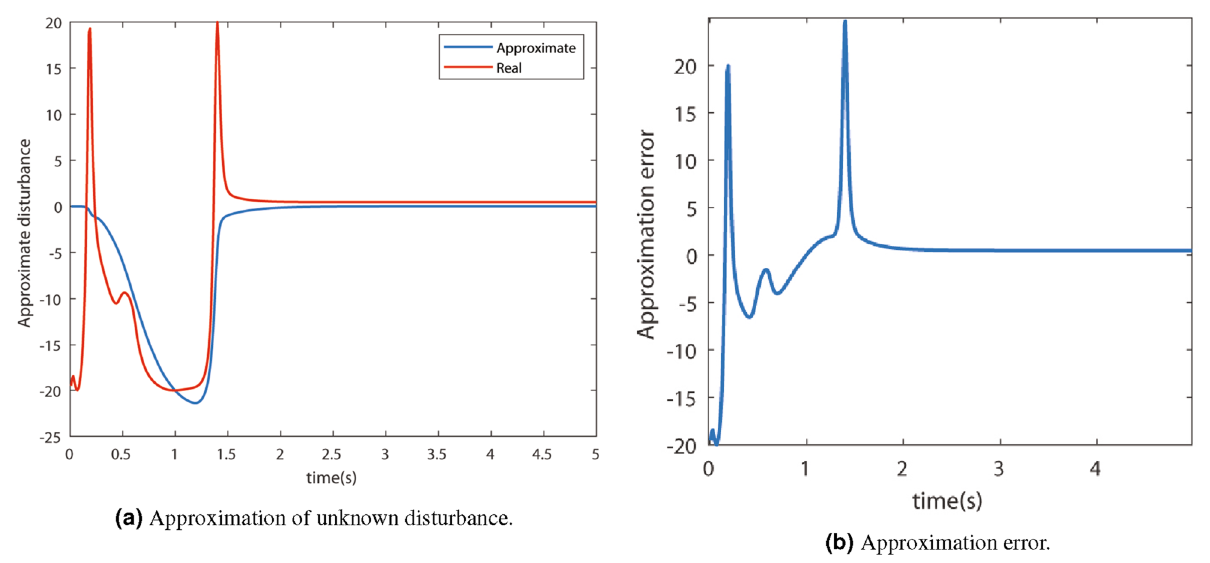
Figure 4. Performance of N-DNDI in approximating unknown external